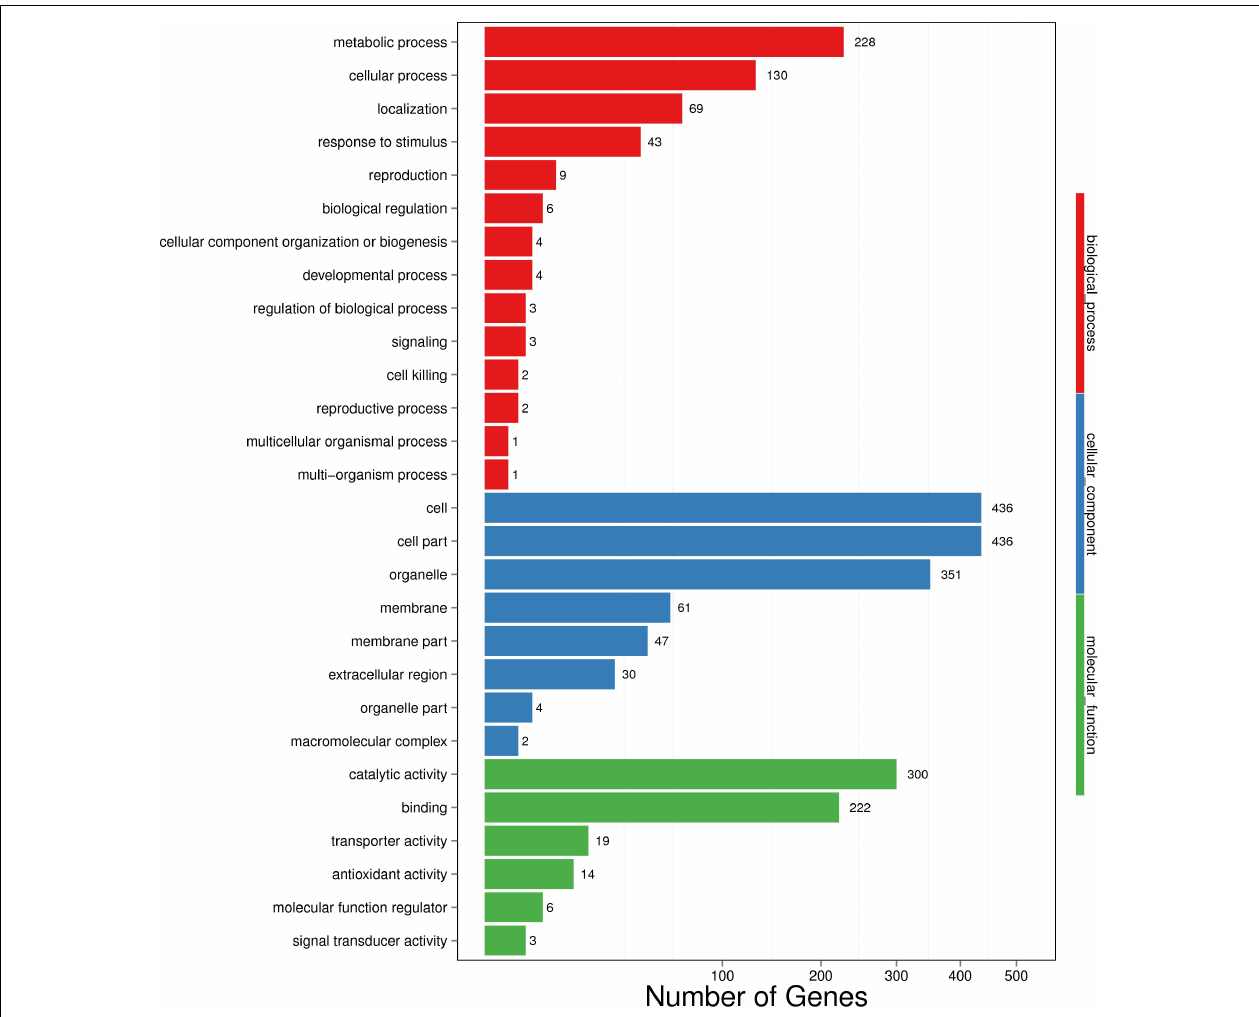
FIGURE 3 | Gene Ontology (GO) enrichment of DEGs identified in wheat. The x -axis represents the number of DEGs. The y -axis represents the GO terms. Functional annotations of assembled cDNA sequences were based on GO term categorization. Transcripts of the DEGs were further classified into 28 functional subcategories, providing an overview of the ontology